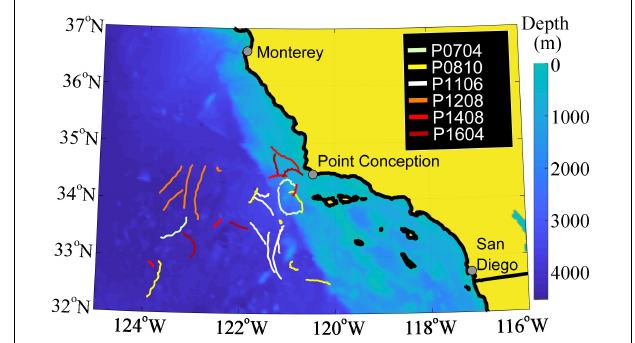
FIGURE 1 | Study region showing Lagrangian tracks of each experimental cycle (color coded by cruise). Blue shading show